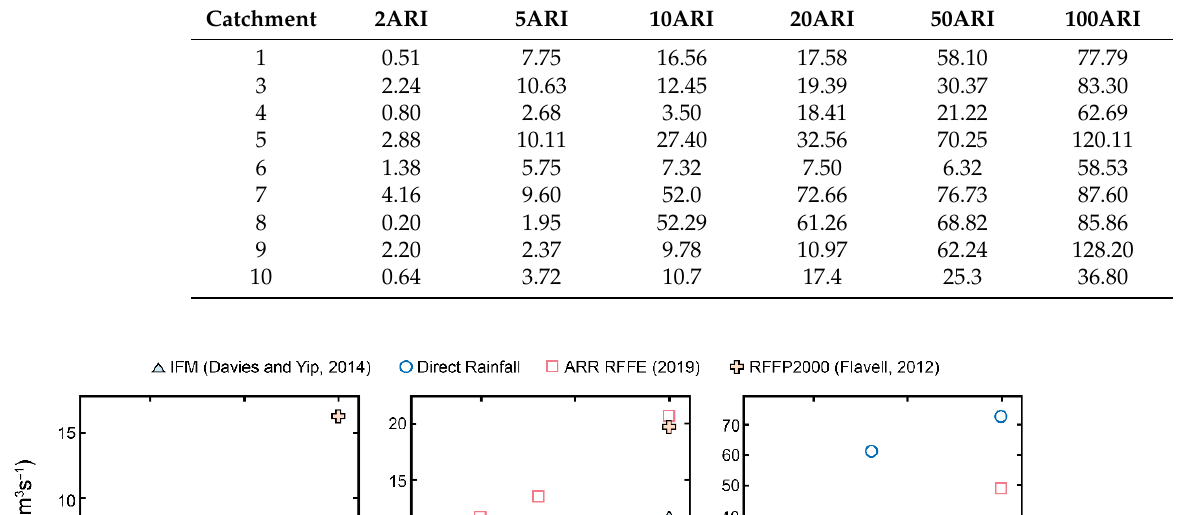
Table 4. Modelled peak discharges using the direct rainfall modelling approach for a 12 h rainfall event across average return intervals. Peak discharge values are in m 3 s − 1 .